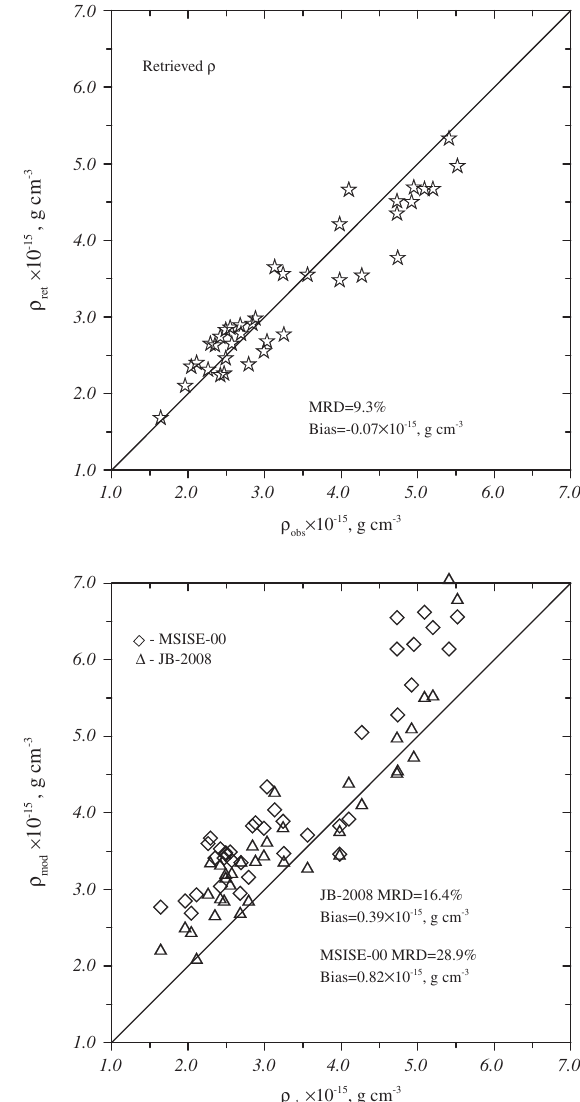
Fig. 1. Distributions of R = q cal / q obs ratio for the retrieved cases with the M2012 method (top panel), and the corresponding distribution based on JB-2008 and MSISE00 neutral gas densities models for solar minimum conditions (middle and bottom panel). The average R ave and the standard deviation SD values are given. The area between dashed lines corresponds to R ave ± SD .